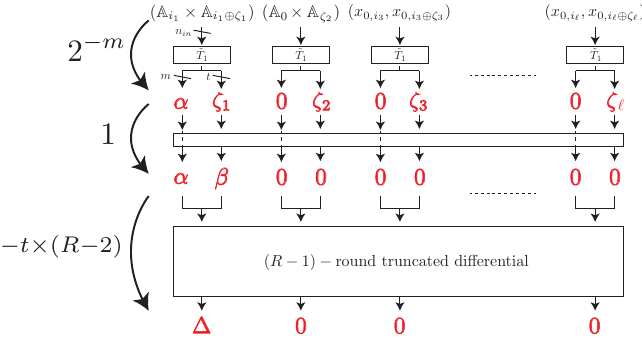
Figure 6: Another truncated differential of Yoroi -core